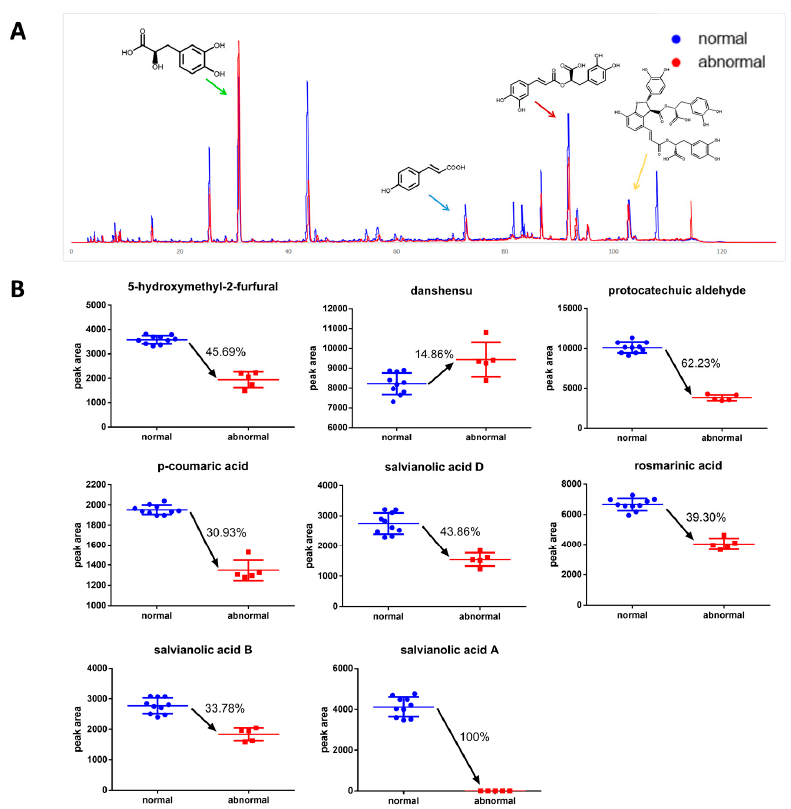
Figure 5. The distinction of the HPLC chromatogram ( A ) and compound content ( B ) between normal and abnormal DHIs.